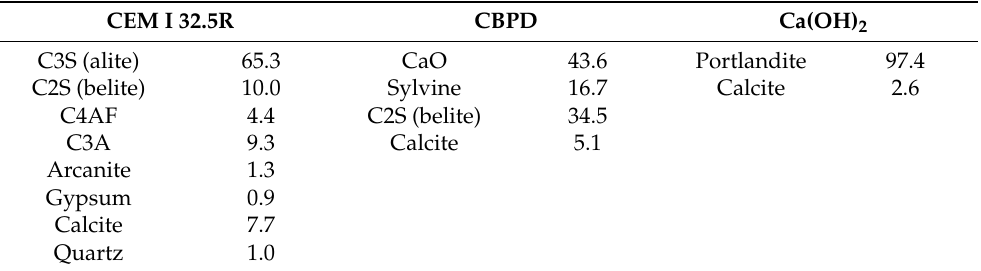
Table 2. Phase composition of raw materials (%).